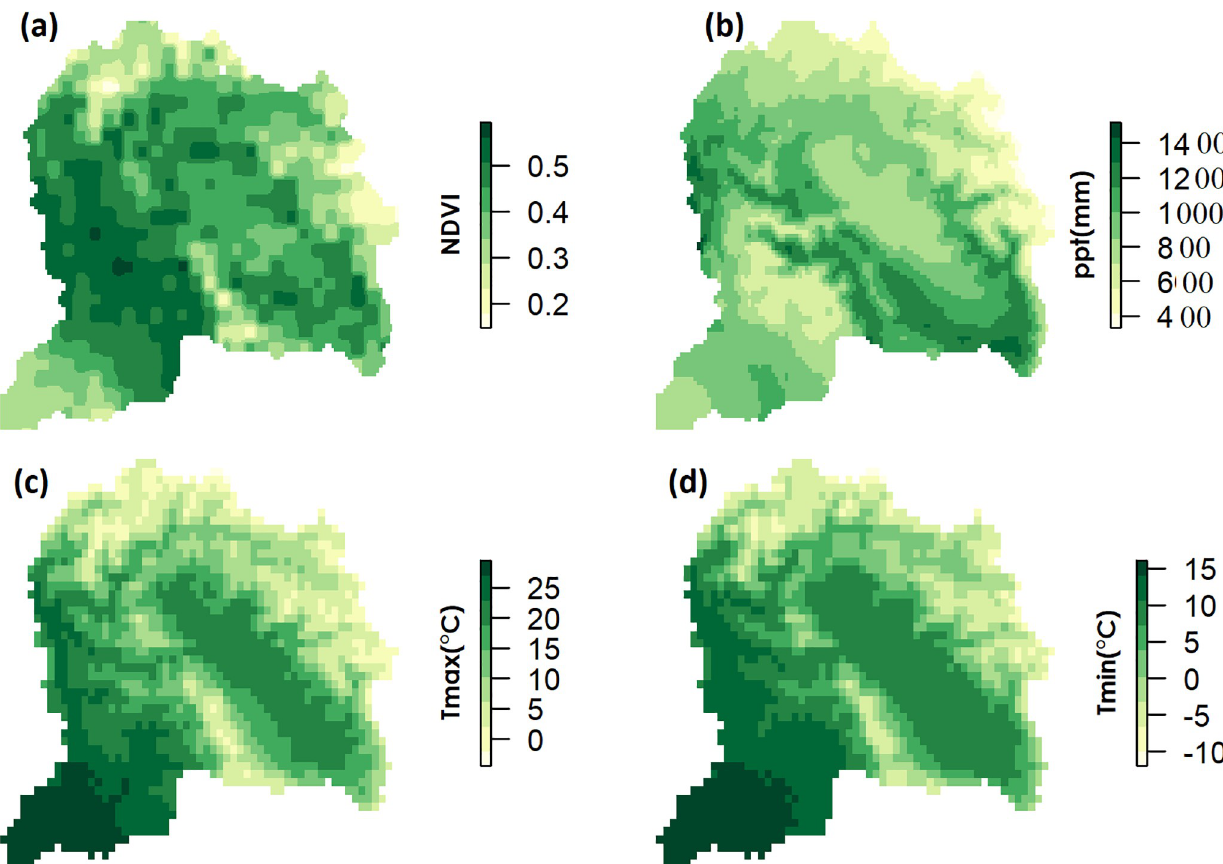
Fig 3. Spatial distribution of average annual NDVI (a), precipitation (b), Tmin (c) and Tmax (d) over the UJRB during 1982 to